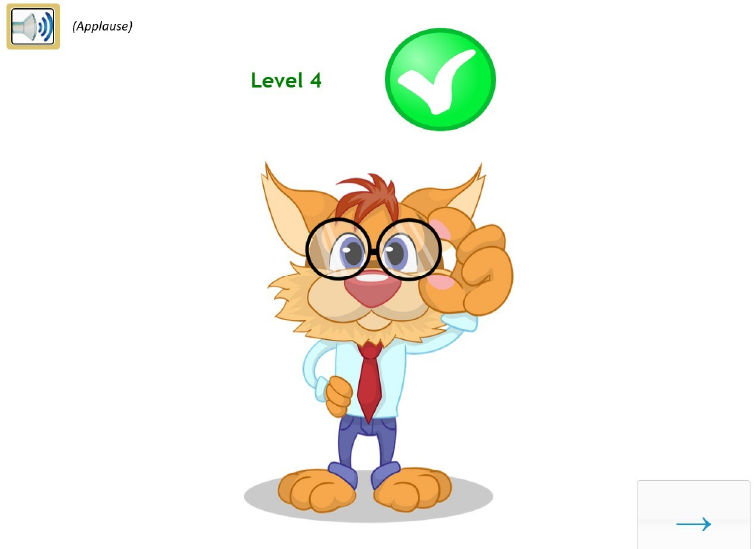
Figure 7. Example of a positive feedback.